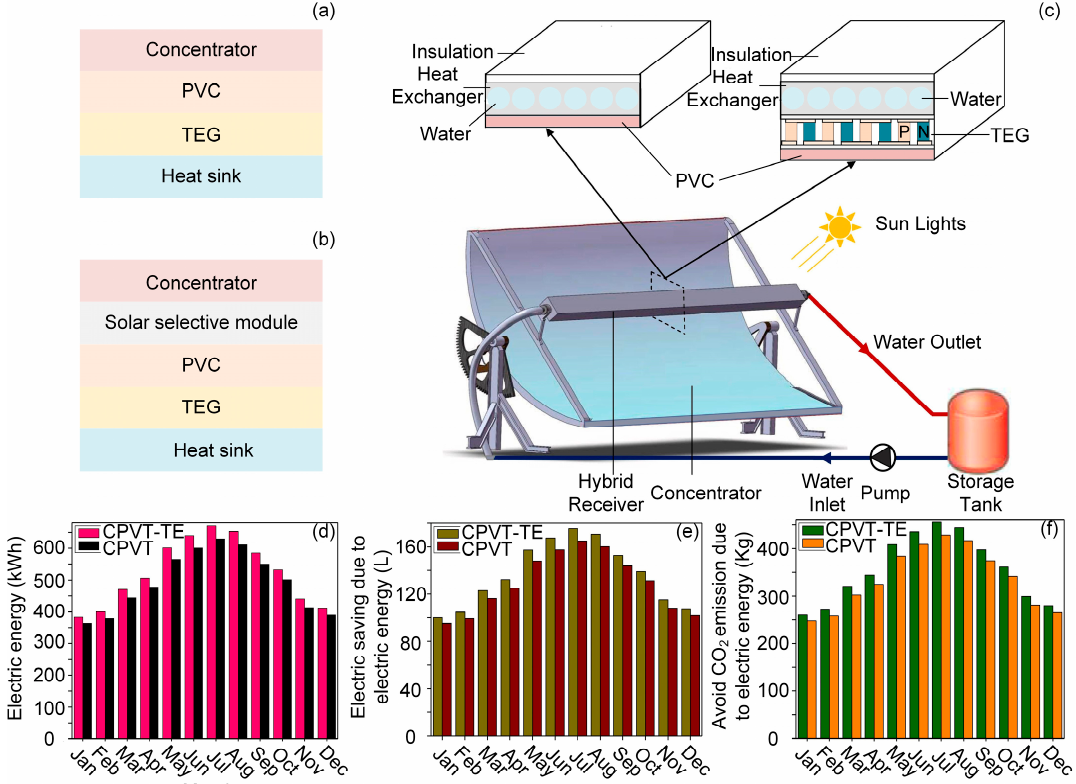
Figure 3. Schematic configuration of ( a ) integrated hybrid system and ( b ) spectrum splitting hybrid system. ( c ) The actual design of the hybrid solar system and the cross-sectional schematics of the receiver. Reprinted with permission from [67]. Copyright 2019, Elsevier. The inset shows the exploded view of the PV module. Monthly distribution of ( d ) the electric energy, ( e ) the energy saving of gasoline, and ( f ) the avoided CO 2 emission due to electric energy production of the CPVT and CPVT–TE system. Reprinted with permission from [67]. Copyright 2019, Elsevier.